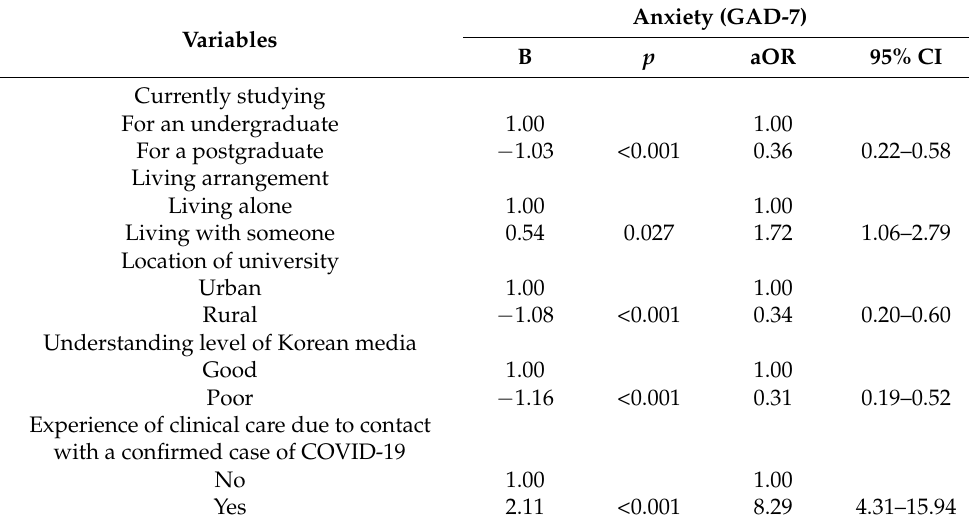
Table 5. Factors associated with depression among international students during the COVID- 19 ( N = 488).